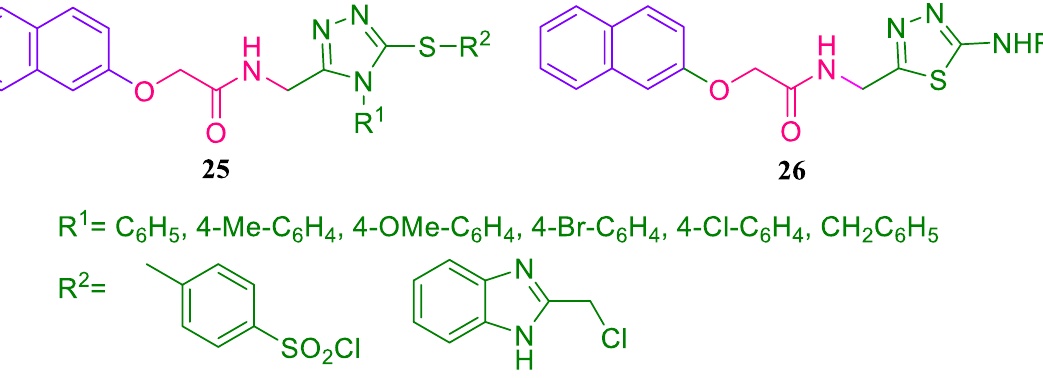
Figure 32. 1,2,4-triazolo-naphthalene and thiadiazole analogues conjugated amino acid